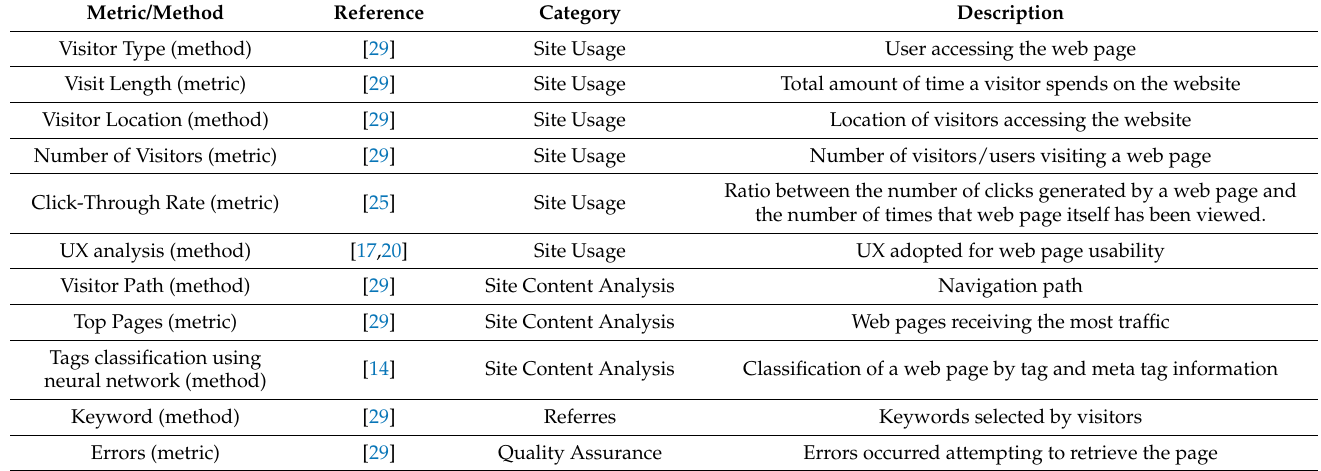
Table 1. List of some metrics and methods for website